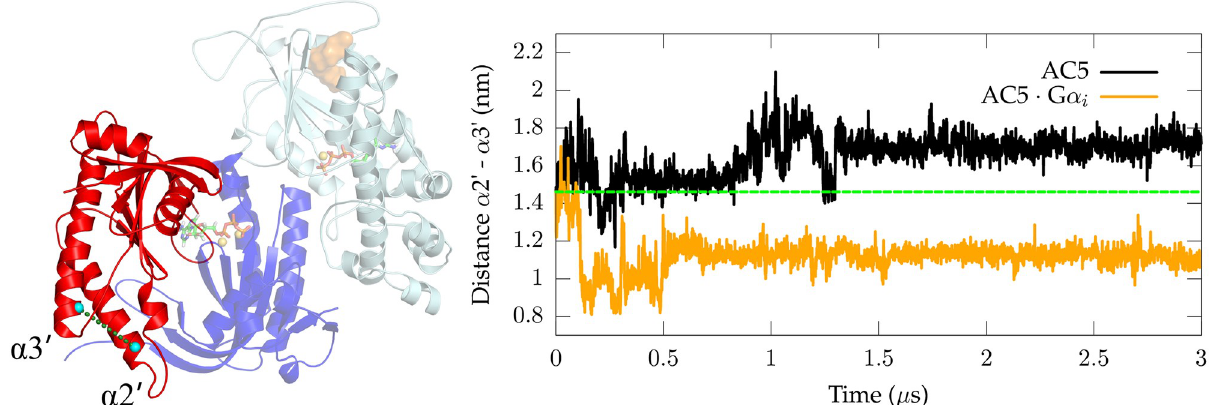
Fig 4. G α binding site. On the left-hand side, the distance between the C-terminal region of α 3’ and the N-terminal region of α 2’ in the C2 domain of olf AC5 is shown as a dotted line. On the right-hand side, the time evolution of the distance between the C-terminal region of α 3’ and the N-terminal region of α 2’ belonging to the G α olf binding site is shown for both simulated systems. The α 2’- α 3’ distance is calculated between the center of mass (COM) of residues 1096-1099 ( α 2’) and the COM of residues 1166-1169 ( α 3’). The green dashed line represents the starting distance between α 2’ and α 3’ in the two simulated systems, coincident in fair approximation to the α 2’- α 3’ distance in the AC:G α s X-ray structure (PDB ID 1CJK).